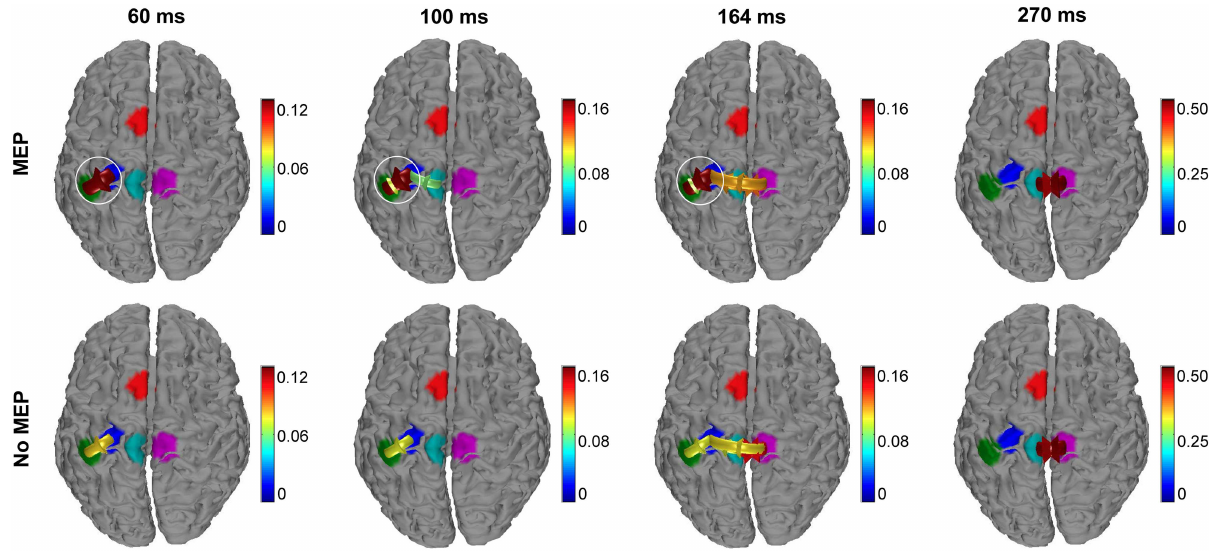
Fig 6. Connectivity patterns amongst ROIs for left M1 stimulation. Arrows indicate significantconnectivity betweenROIs at the 60ms (left), 100ms (middle left), 164 ms (middle right), and 270 ms (right) latencies(averageof 11 participants with simultaneous EMG recording). The color of the arrow indicatesthe strength of the connection. White circles emphasize differencesin connectivity patterns amongst trials with MEPs (top) and without MEPs (bottom).